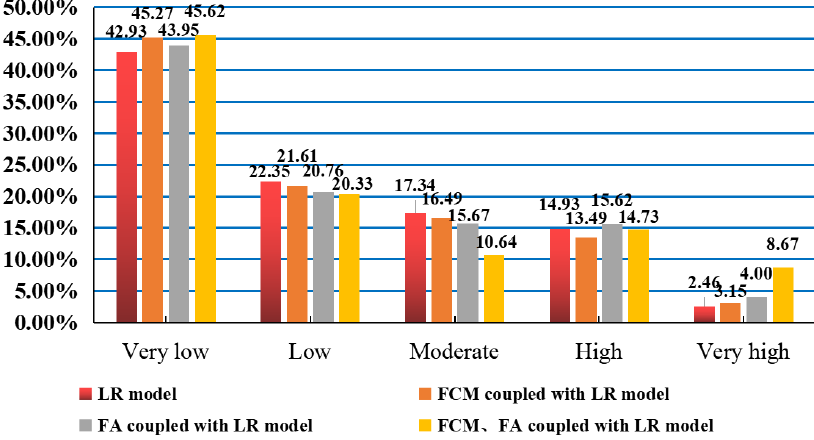
Figure 9. The percentage of the different susceptibility classes.